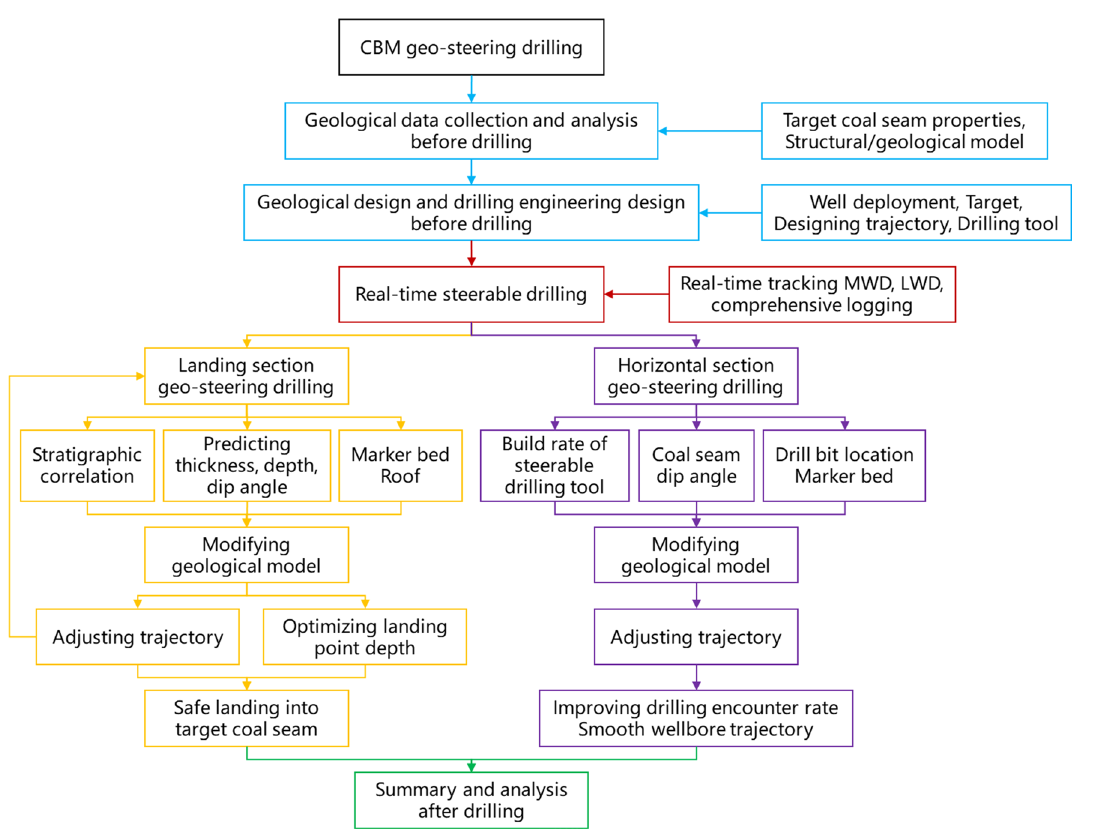
Fig. 20 Flow chart of geo-steering drilling for CBM horizontal